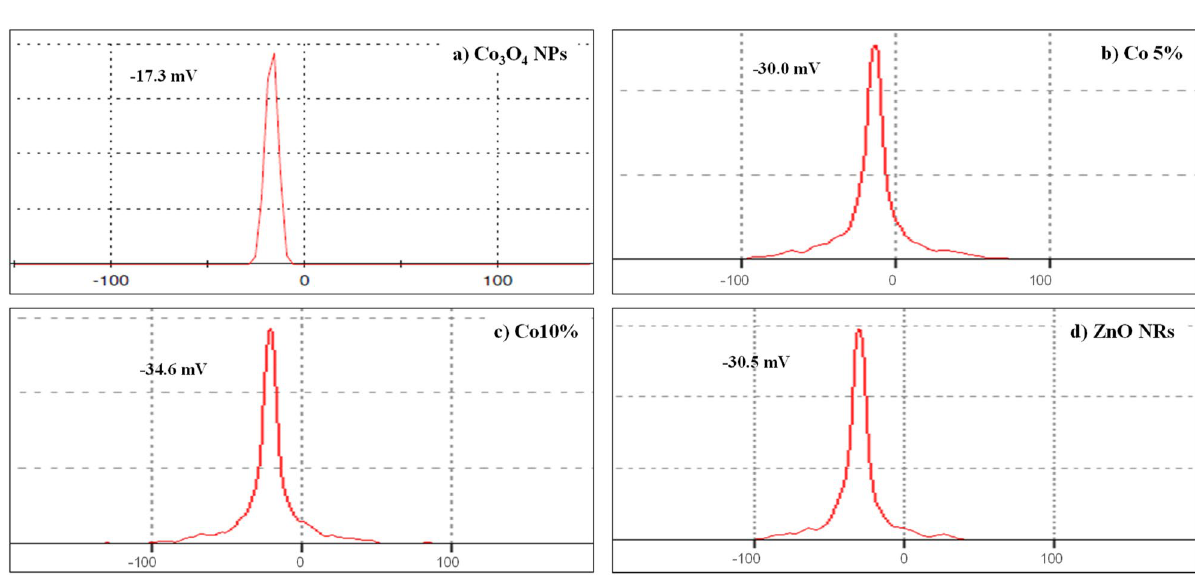
Figure 10. DLS particle size distribution of ( a ) Co 3 O 4 NPs, ( b ) Co 5%, ( c ) Co 10% and ( d ) ZnO NRs.